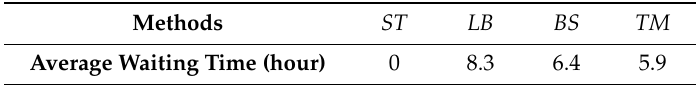
Table 7. Average waiting time of batch-type jobs on a cloudy (rainy) day.